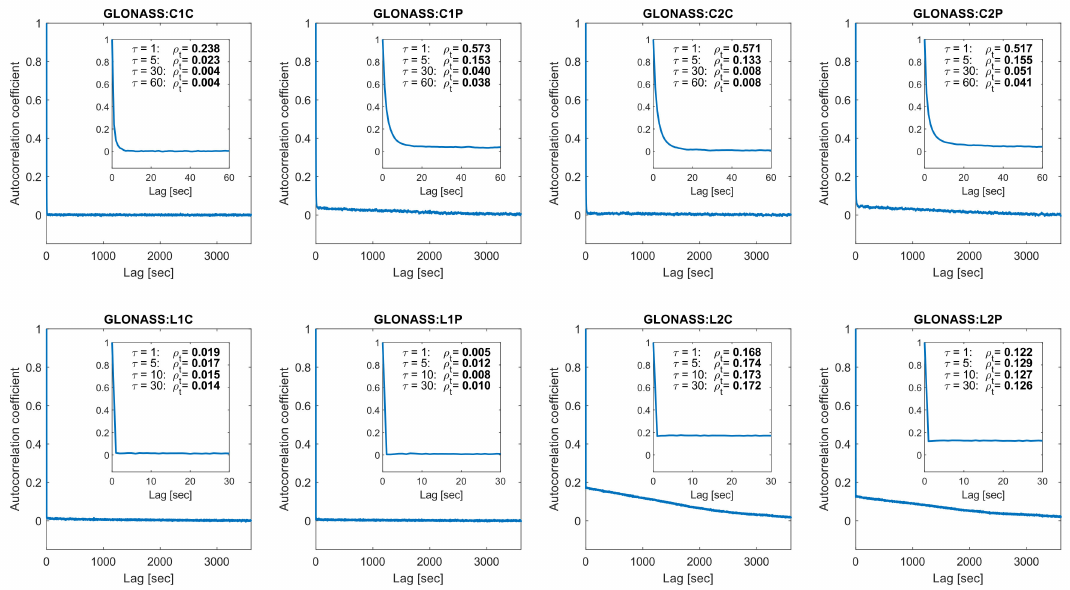
Figure 5. Sample autocorrelation coefficients for GLONASS observations (2019 DOY: 055).